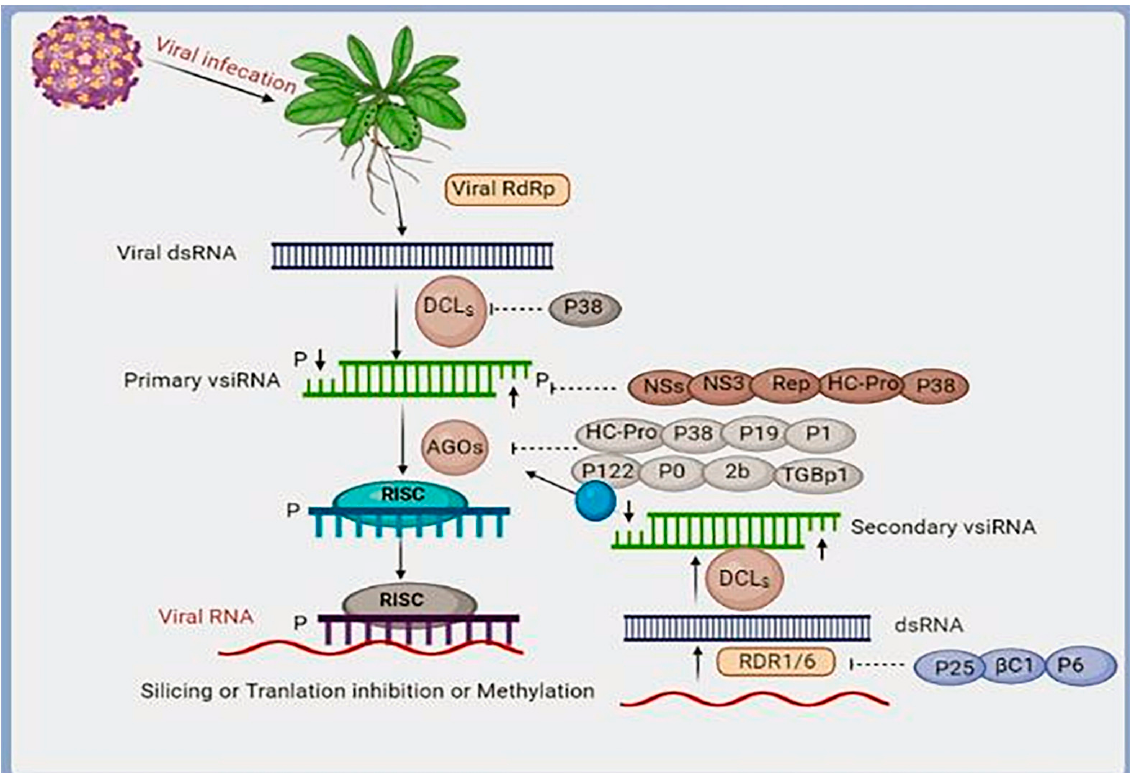
Figure 7. An RNAi-based antiviral mechanism in Arabidopsis. Following viral infection, the double- stranded viral RNA replication intermediate is recognized and processed by DCL4, DCL2, or DCL3, producing 21, 22, or 24 nucleotide duplex primary viral siRNAs. These viral siRNAs will be uploaded into AGO1 or AGO2 to create RISC and induce RNA virus slicing or translation inhibition via